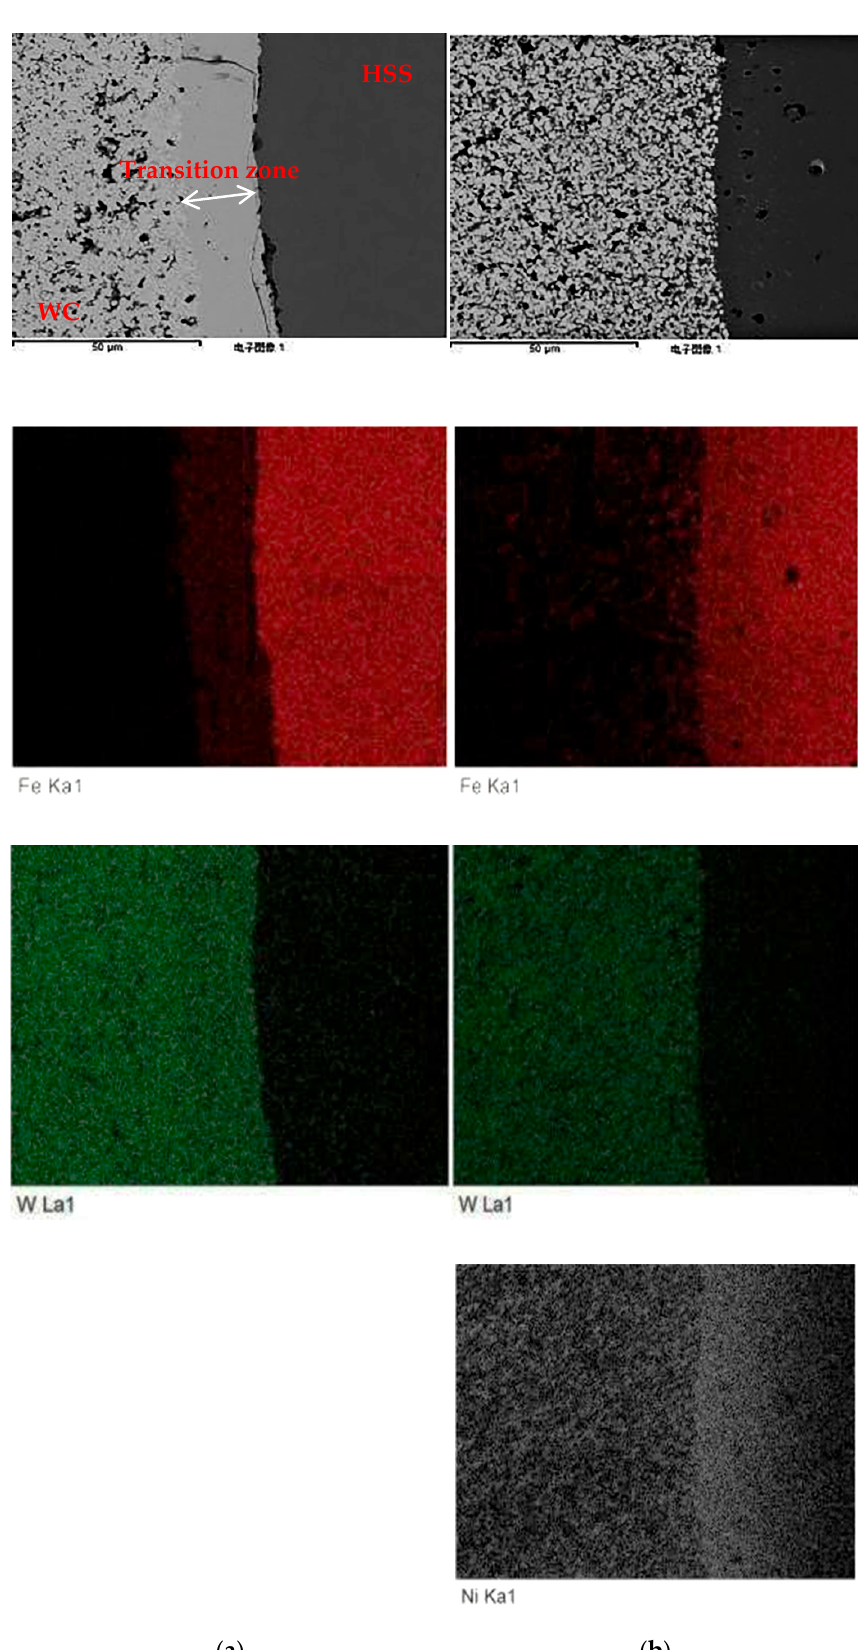
Figure 6. Composite interface scan of surface elements: ( a ) no Ni added; ( b ) Ni added.